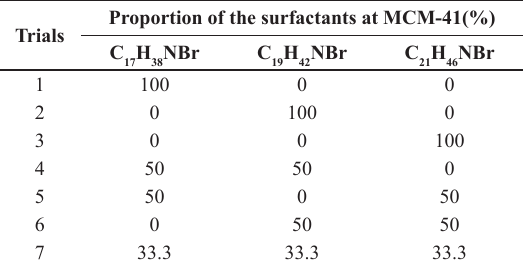
Figure 1. Representation of the experimental space “simplex” of three independent variables. Table 1. Trials obtained by planning